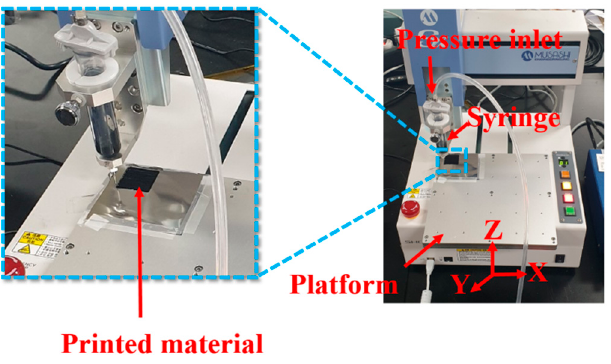
Figure 2. Optical image of the printed MWCNTs/AC/BNNTs ternary composite material.